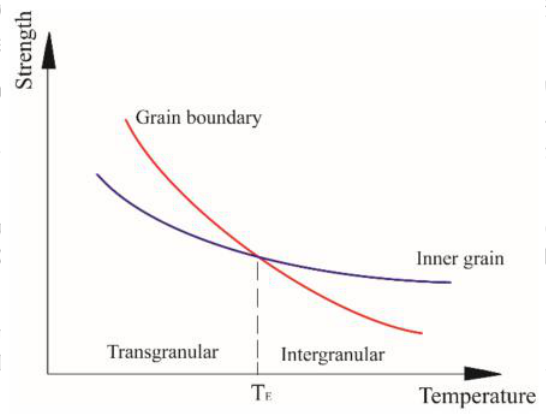
Figure 11. Schematic temperature-dependent fracture: transgranular versus intergranular.